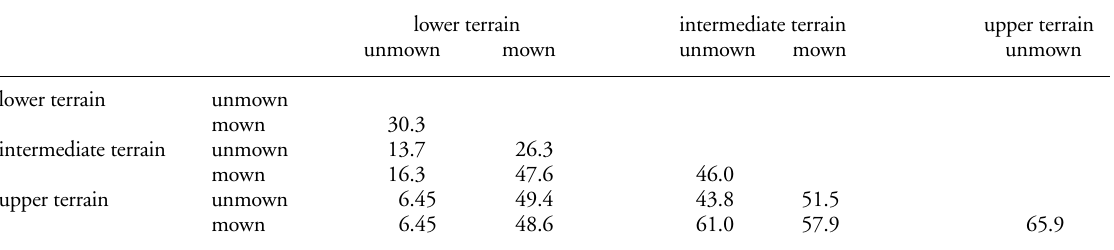
Table 2. Renkonen similarity of Auchenorrhyncha communities on different treatment plots (data are from suction trap, sampling season: May 1998). Values are expressed as percent. lower